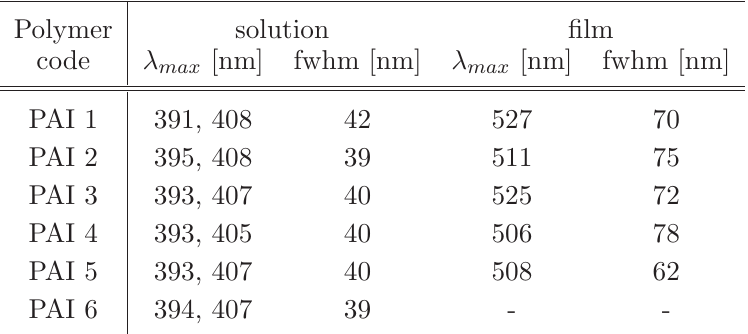
Table 4 Photoluminescence data of the